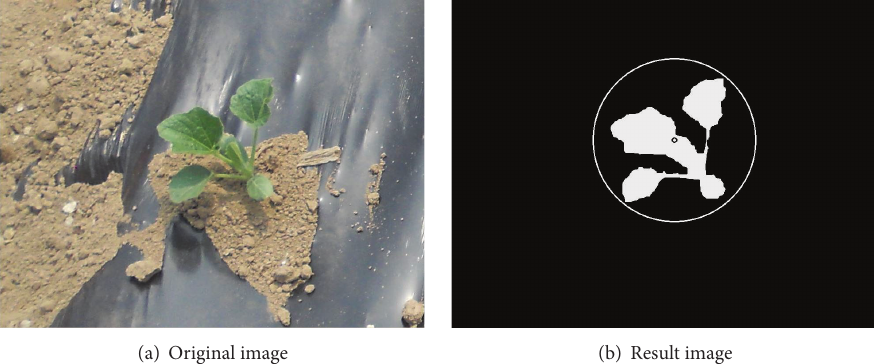
Figure 7: Segmentation and feature extraction of eye-in-hand camera image.